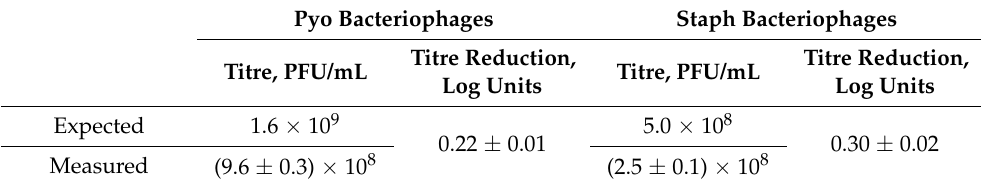
Figure 4. Plaques formed in the agar overlay by the bacteriophages in the biopolymer solutions. Quantitatively, the number of bacteriophages in the Na-alginate solution was com- pared with the expected number, and a reduction of titre was calculated in each case (Table 1). Table 1. Titre of the bacteriophages in 1.0%( wt / vol ) Na-alginate solution.